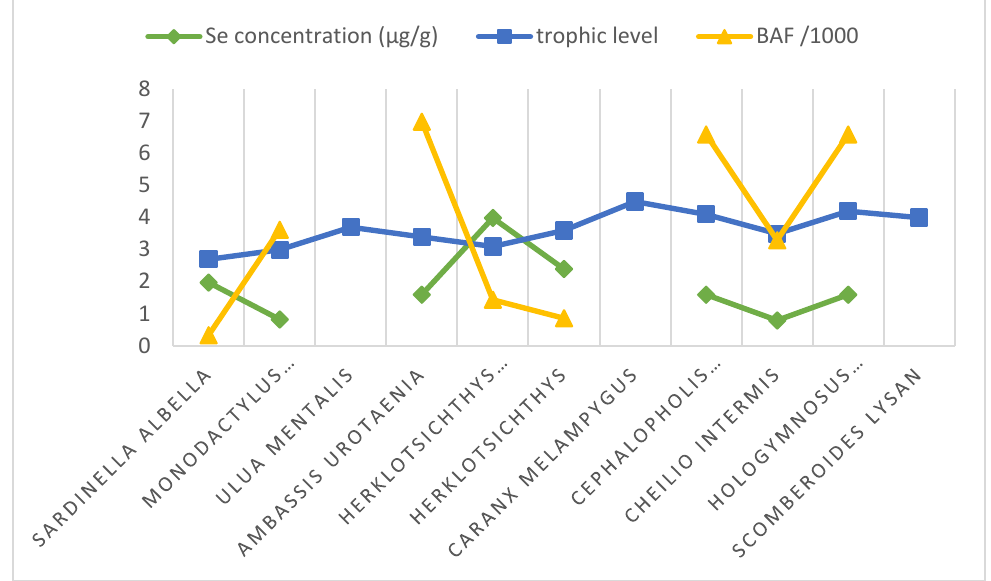
Figure 6. Comparison of selenium concentration among fish species using the bioaccumulation factor and trophic level. Table 4. Fish species ’ biological, physical, and chemical properties, collected from